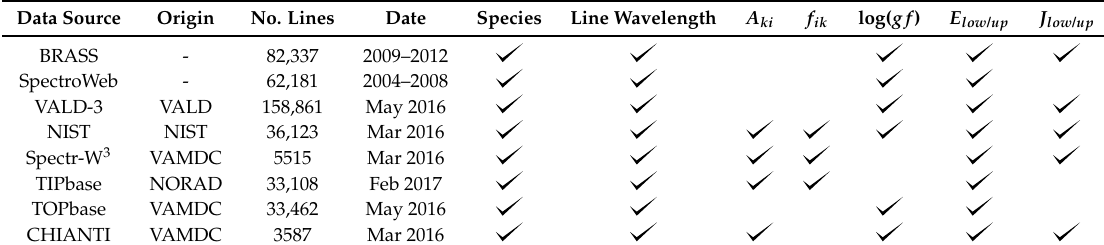
Table 1. Overview of the retrieved number of lines for BRASS from various atomic databases, including the retrieval dates and types of atomic data per